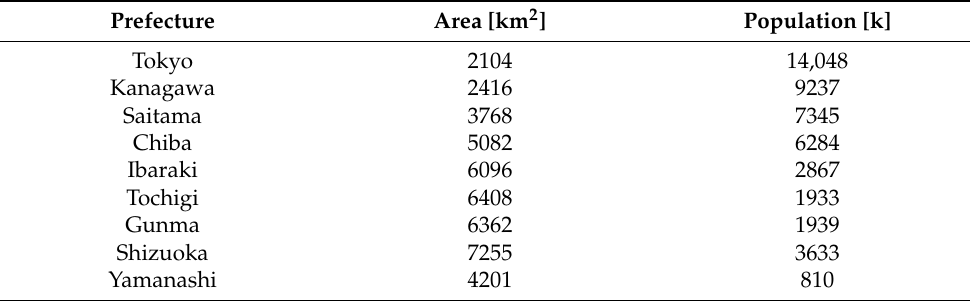
Figure 3. Radius of 100 km centering on Nihonbashi, Tokyo, and scene of measurement in front of Mt. Fuji (inset). Table 2. Area and population of each prefecture in 2020.